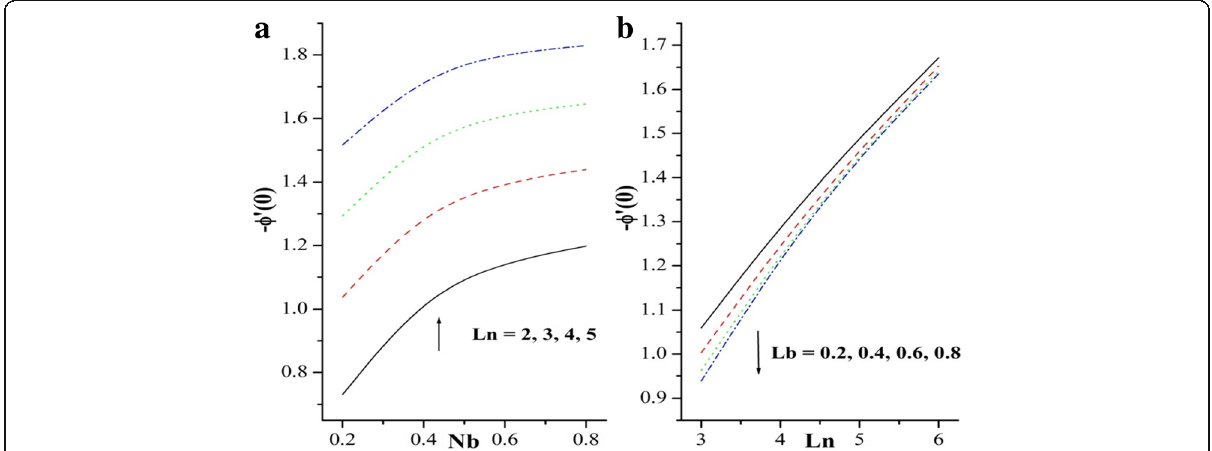
Fig. 19 a , b Influence of Nb and Ln with the various values of Ln and Ld on Sherwood number,